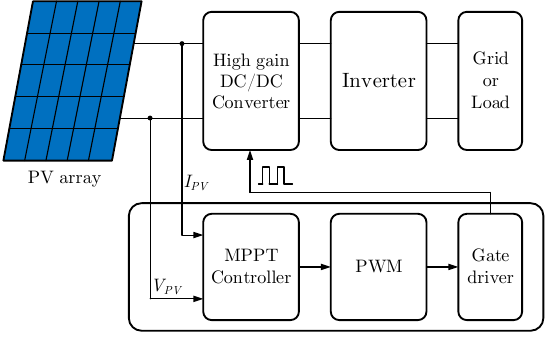
Figure 3. Structure of a typical